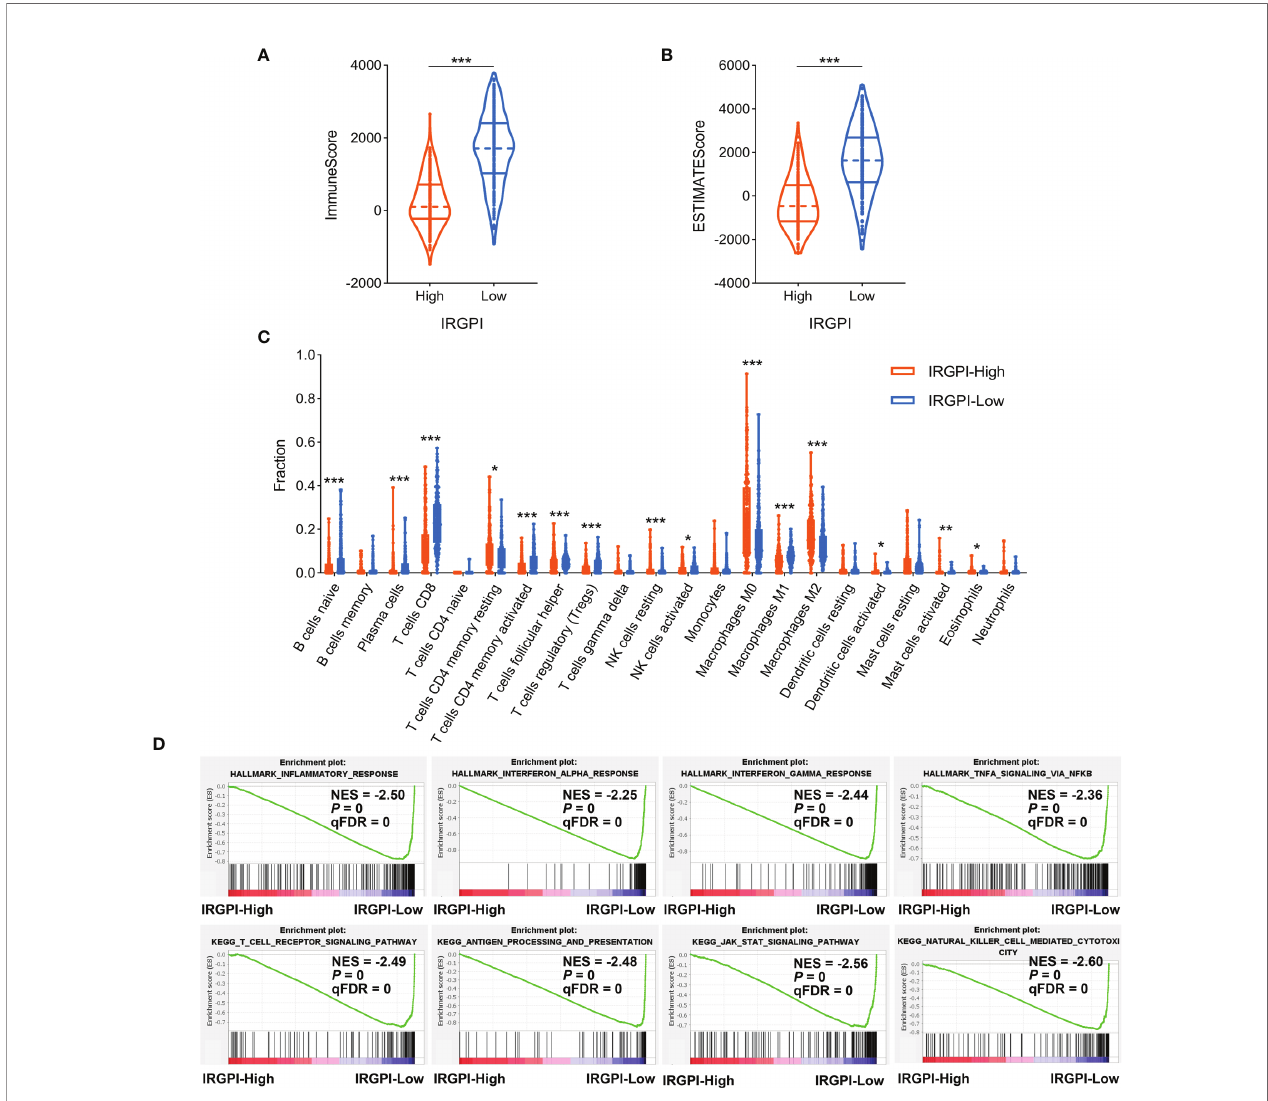
FIGURE 4 | Comparison of immune microenvironment characteristics according to IRGPI status. (A, B) ESTIMATE algorithm revealed the ImmuneScore and ESTIMATEScore between IRGPI-high and IRGPI-low groups. (C) Evaluation of 22 immune cell in fi ltrating using the CIBERSORT method. (D) GSEA plots of immune- related pathways in comparison between IRGPI-high and IRGPI-low groups. IRGPI, immune-related gene pair index; GSEA, gene set enrichment analysis. * P < 0.05, ** P < 0.01, *** P <